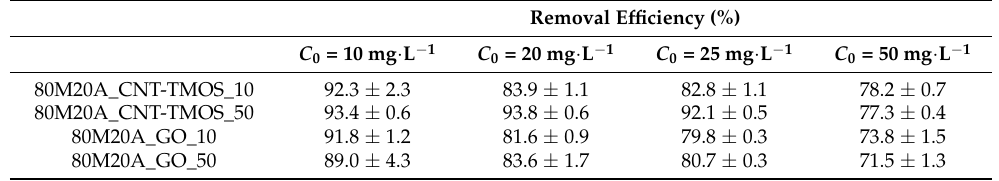
Table 6. Removal efficiency of the carbon nanotubes and graphene oxide–silica aerogel composites with two amounts of carbon nanostructure for different initial concentrations of